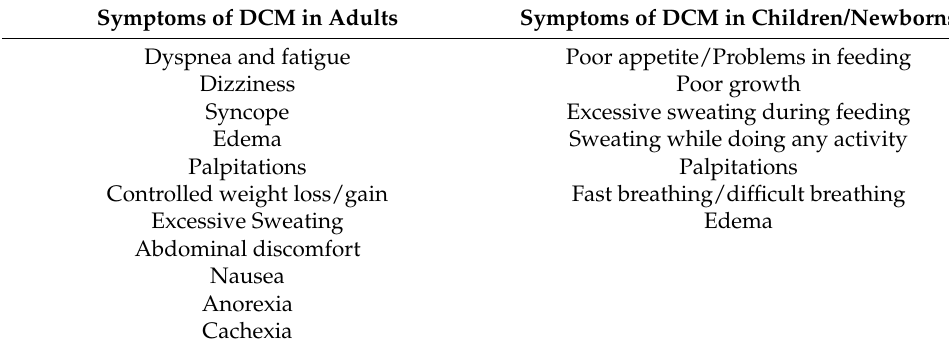
Table 1. Symptoms of DCM in adults and children